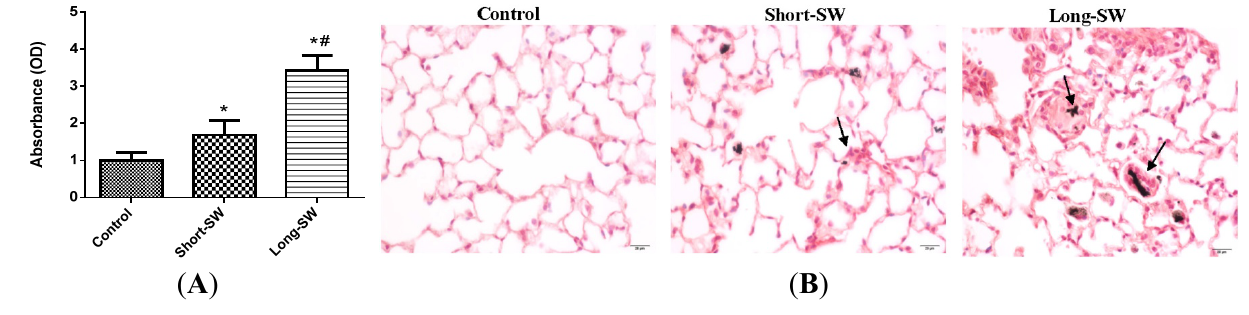
Figure 5. Effect of SWCNT length on fibrogenic response in vivo . Mice were exposed to 50 µL of dispersed SWCNT (40 µg/mouse) via pharyngeal aspiration for 90 days after which the animals were sacrificed and the lungs were isolated, lysed and analyzed for ( A ) soluble collagen content by Sircol ® assay; ( B ) histopathology after Sirius red staining. Scale bar = 20 μ m; Arrows denote the thickening of collagen fibers around the CNT; Values are means ± S.D., ( n = 5 mice per group); * p < 0.05 vs. BSA/dipalmitoyl phosphatidylcholine (DPPC) treated control; # p < 0.05 vs. Short-SW